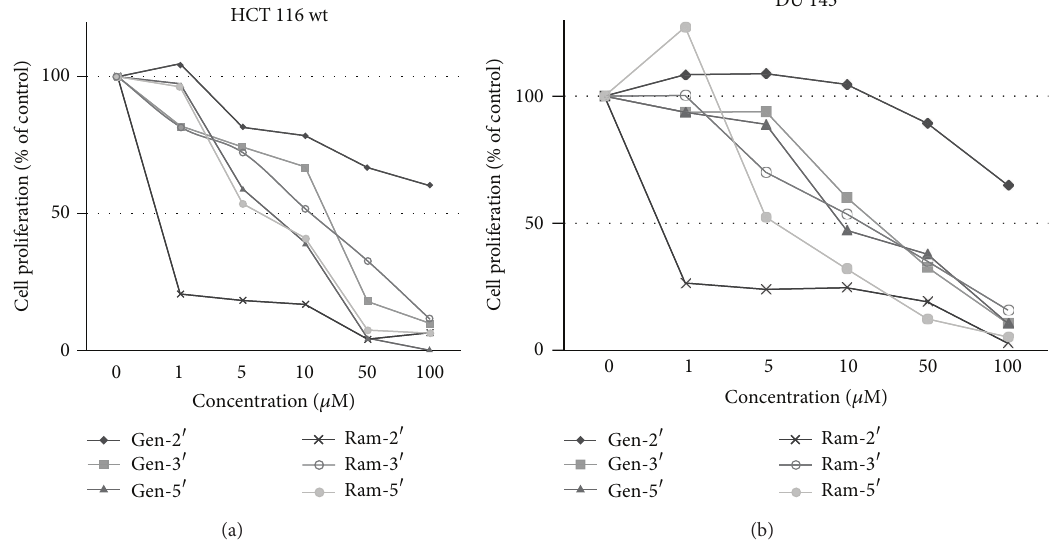
Figure 3: Inhibition of proliferation of cancer cells by genistein derivatives substituted at C4 󸀠 .